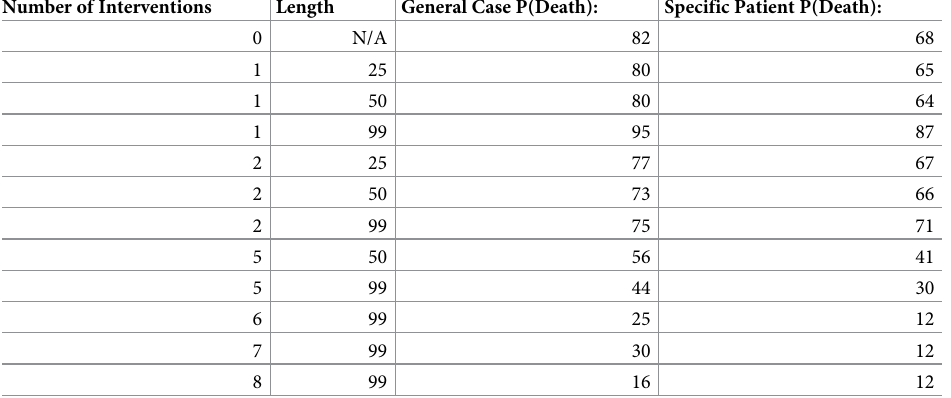
Table 1. Number of